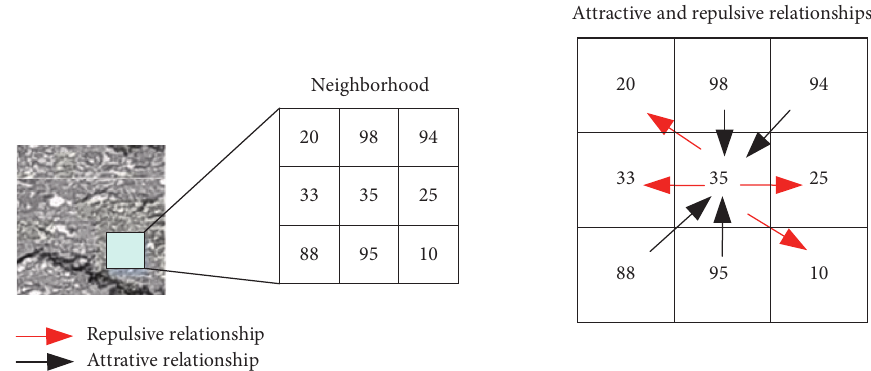
Figure 5: Demonstration of attractive and repulsive relationship of